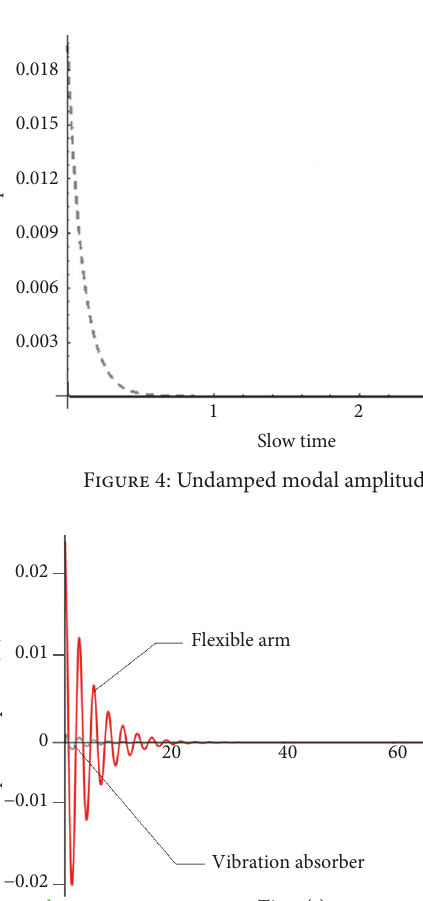
Figure 3: Undamped modal amplitudes.